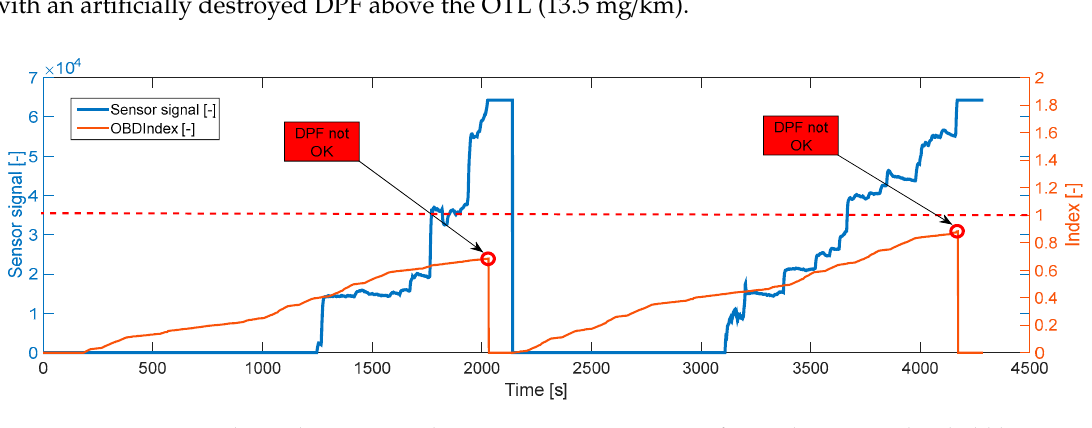
Figure 10. OBD index and sensor signal across a transient operation for an above OBD threshold limit (OTL) DPF. Both sensor accumulation periods result in a correct diagnosis of the failed DPF.